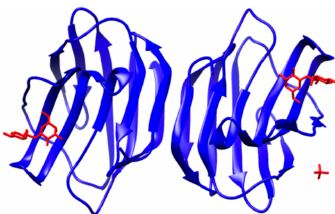
Figure 1. Dimeric structure of galectin-1. Galectin-1 ( blue ) with lactose ( red ) bound in the apposing carbohydrate recognition domains. Reproduced with permission from Reference [52].